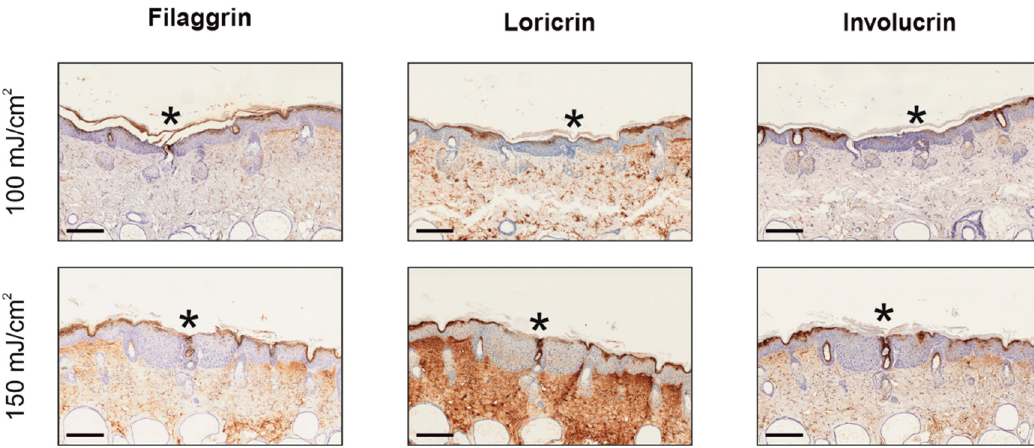
Figure A1. Immunostaining of incidental AKs (*) surrounded by reactive epidermis in the skin of CFC. The upregulation of filaggrin, loricrin, and involucrin is observed in the reactive epidermis (upper layers) after chronic UV-B irradiation, while incidental AKs showed lower or null immunostaining for these differentiation markers. The scale bar represents 200 µm.